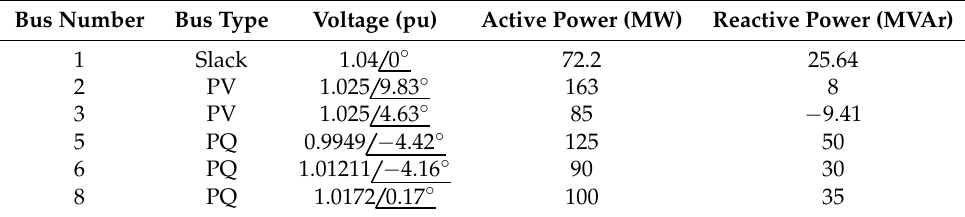
Figure 5. One line diagram of the IEEE 9 bus model. The inverter-based frequency response has been added at the same bus of the generating units. Table 5. Steady state initial conditions of the